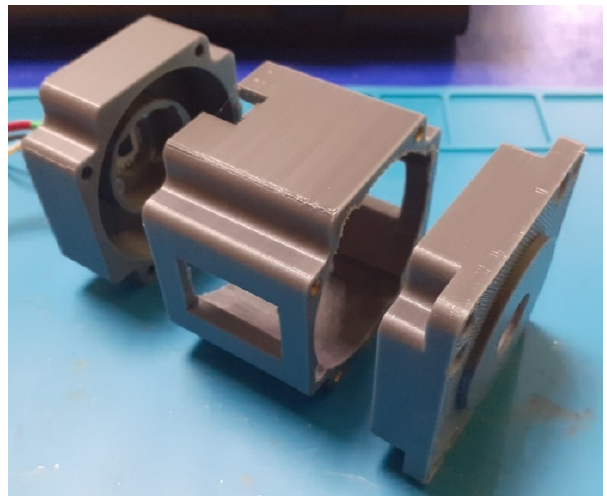
Figure 12. The housing of the layout.